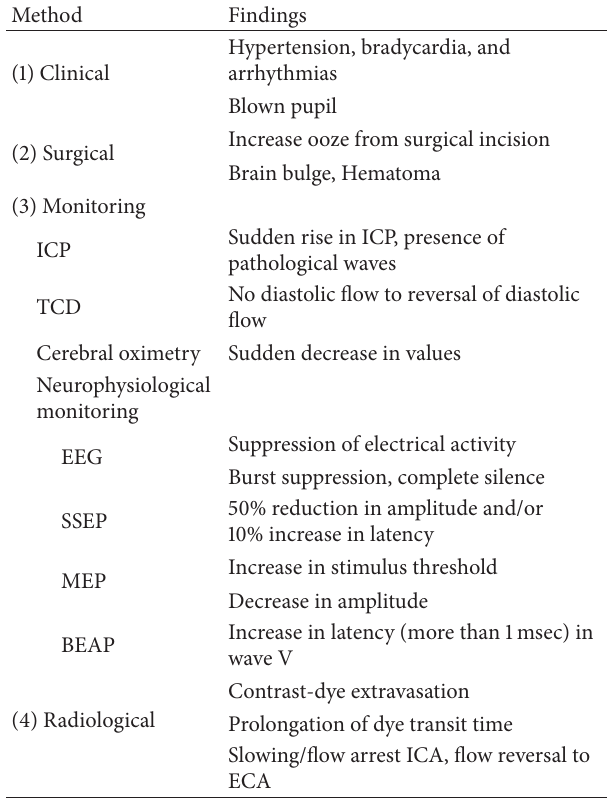
Table 2: Diagnosis of